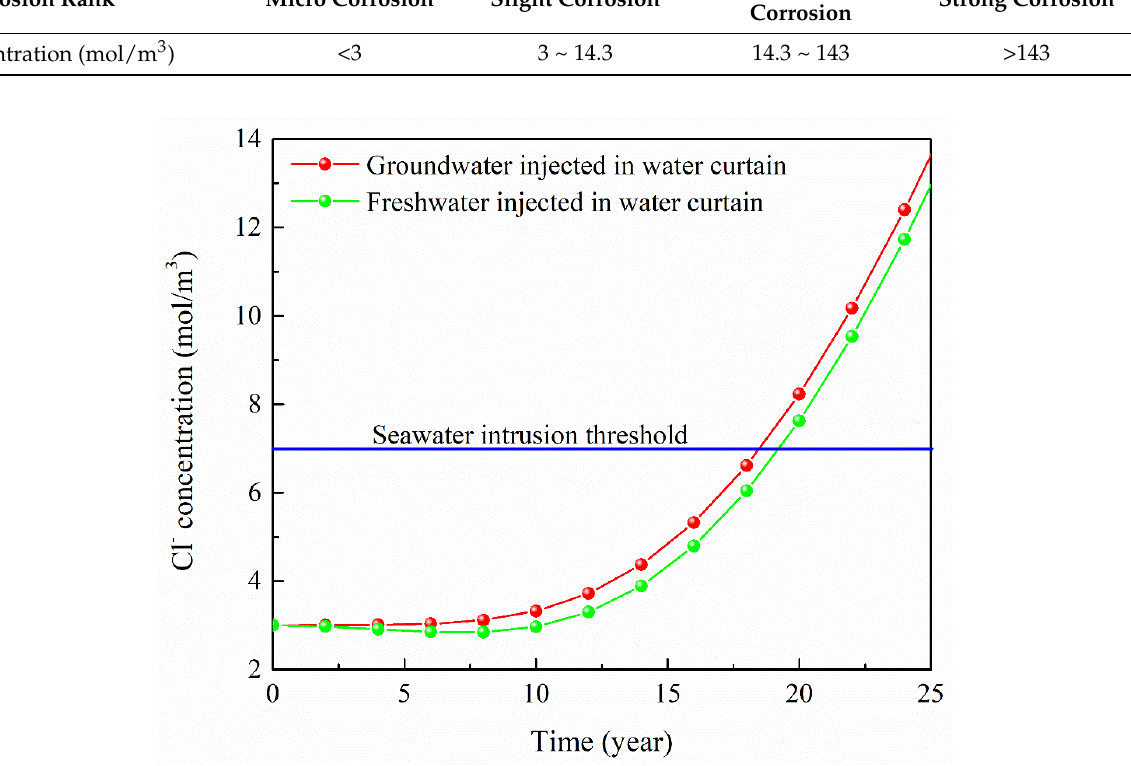
Figure 19. Cl − concentration on the southeast side of the bottom of Cavern #2 with time.